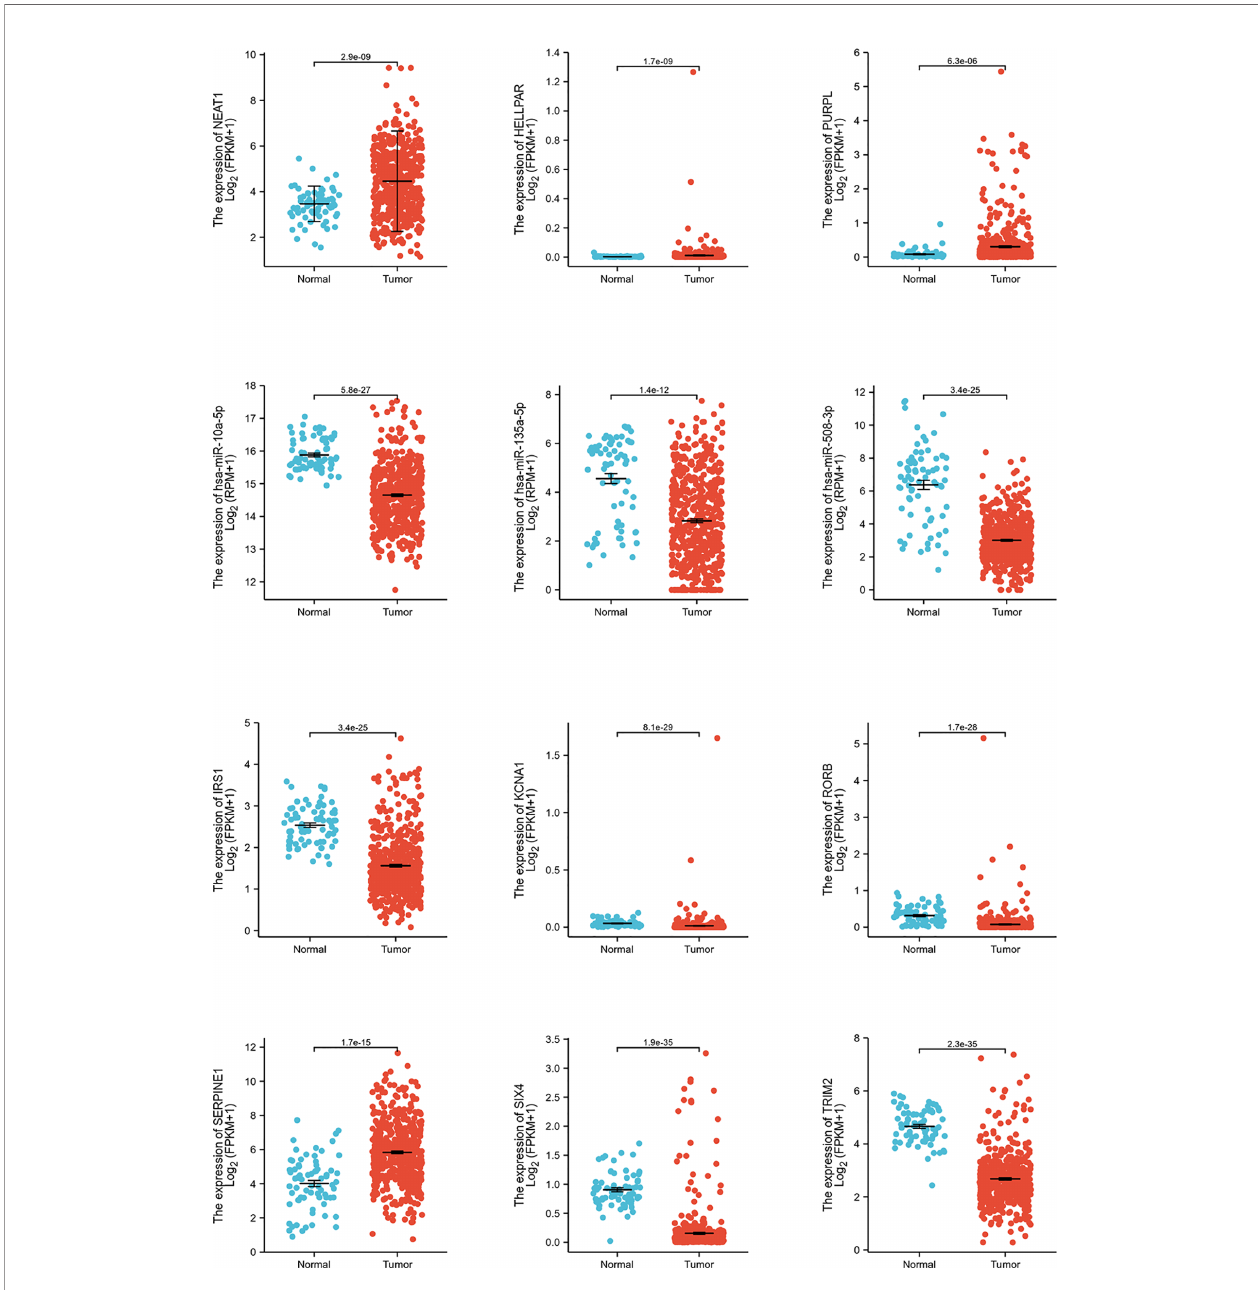
FIGURE 5 | Hub genes expression analysis. Expression analysis of 12 hub genes (3 lncRNAs, 3 miRNAs, 6 mRNAs) comparing tumor and normal